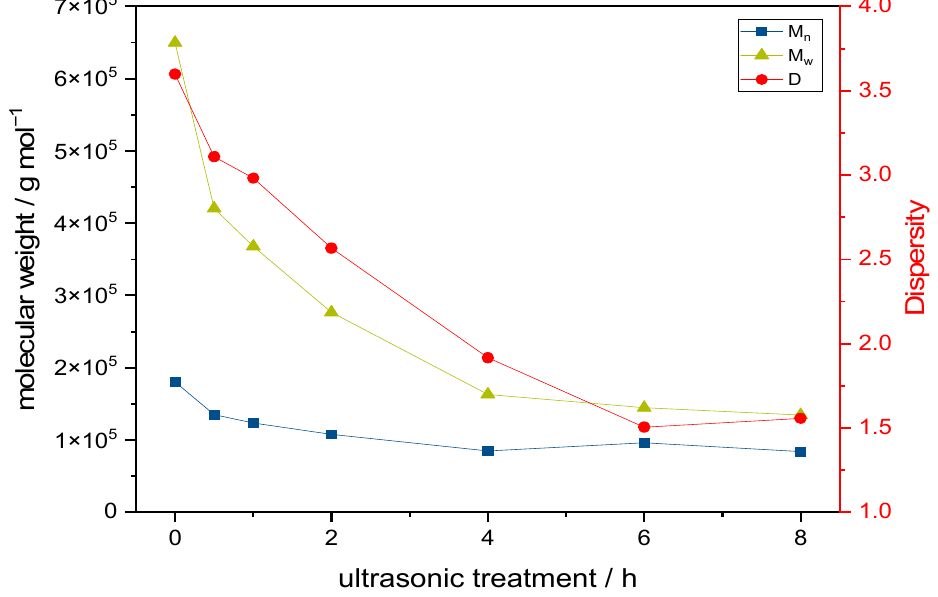
Figure 7. Polymer degradation and polymer weight distribution of keto-HPC DOx1.5 via ultrasonic treatment.